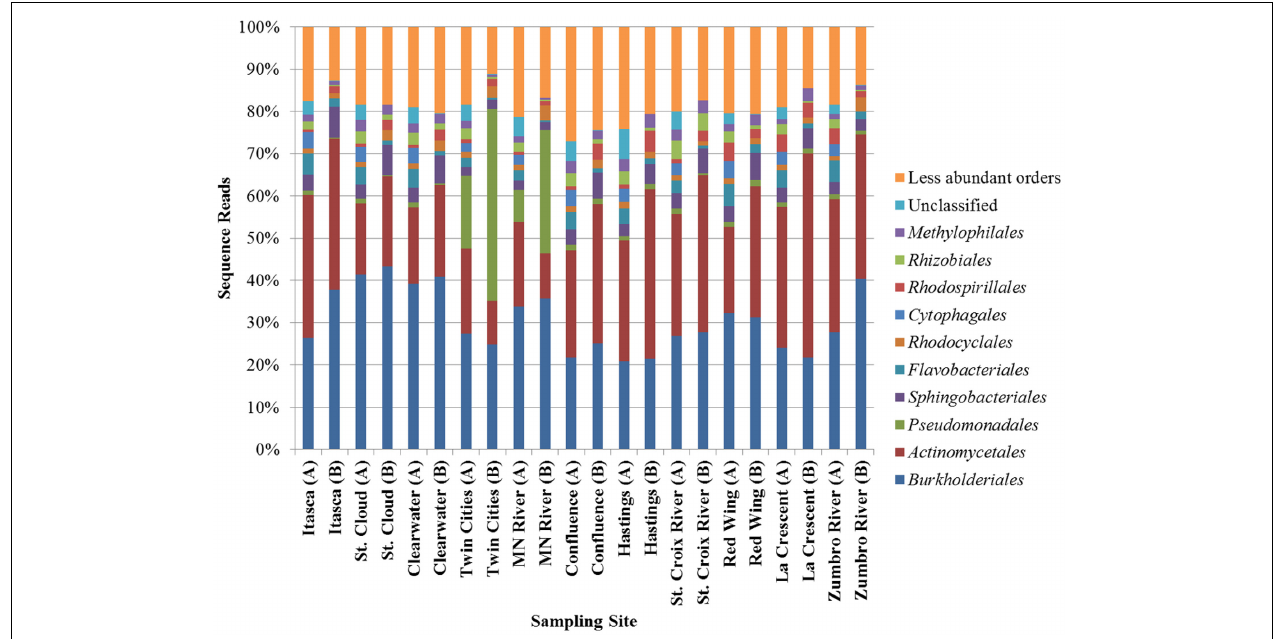
FIGURE 2 | Distribution of abundant orders determined by metagenomic shotgun sequencing (A) or 16S rRNA sequencing